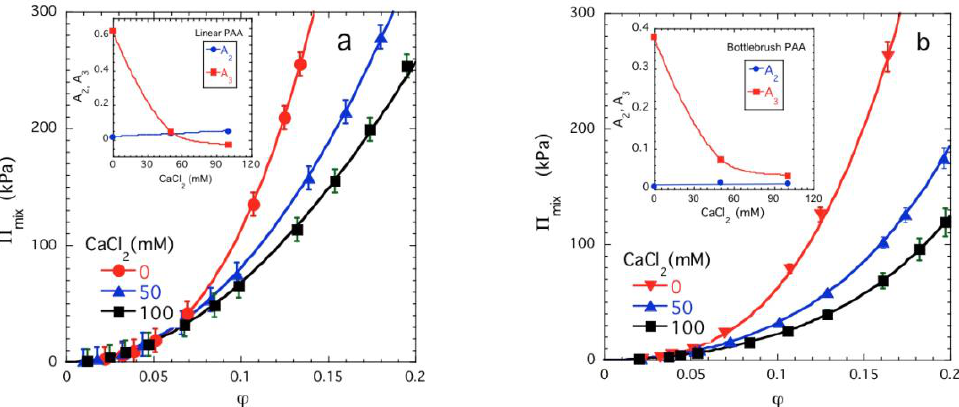
Figure 6. Mixing pressure Π mix versus polymer volume fraction φ plots for linear ( a ) and bottle- brush ( b ) PAA solutions in CaCl 2 solutions. The continuous lines show fits of Equation (3) to the experimental data and the variation of A 2 and A 3 as a function of the CaCl 2 concentration is shown in the insets. Note that A 2 is very small and practically independent of the Ca salt concentration, A 3 decreases with added Ca salt, but in the solution of the bottlebrush polymer it does not become negative. Accordingly, the latter solutions are relatively stable against phase separation in the form of a volume transition. The data uncertainties are estimated by one standard deviation of the linear regression fit parameters.